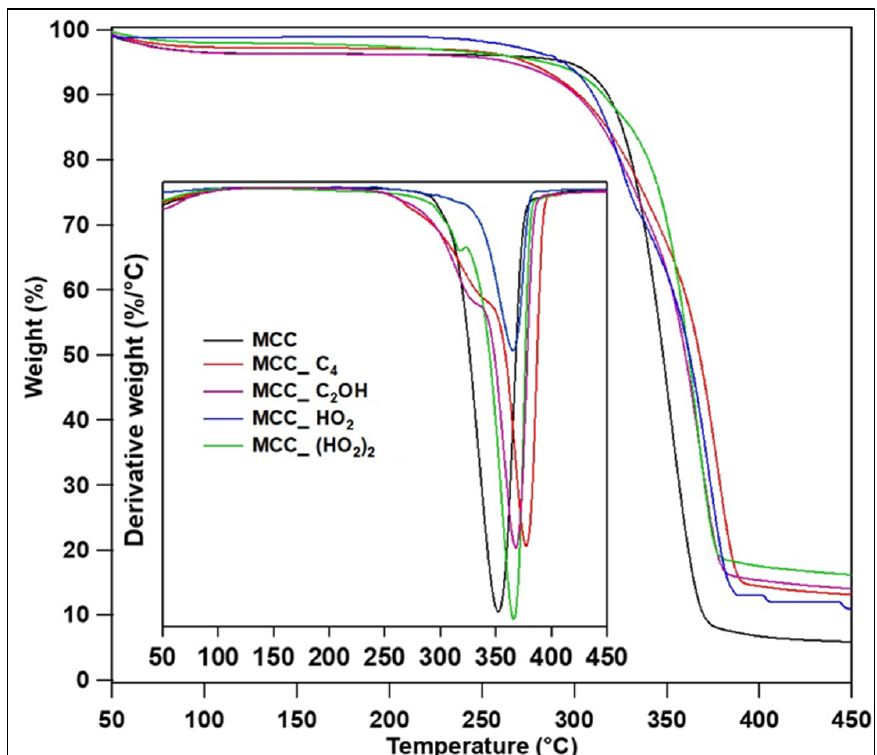
Figure 5. TG and DTG curves for the IL-treated MCC. Table 1. Summary of the thermal decomposition data of the MCC samples, determined by TGA.